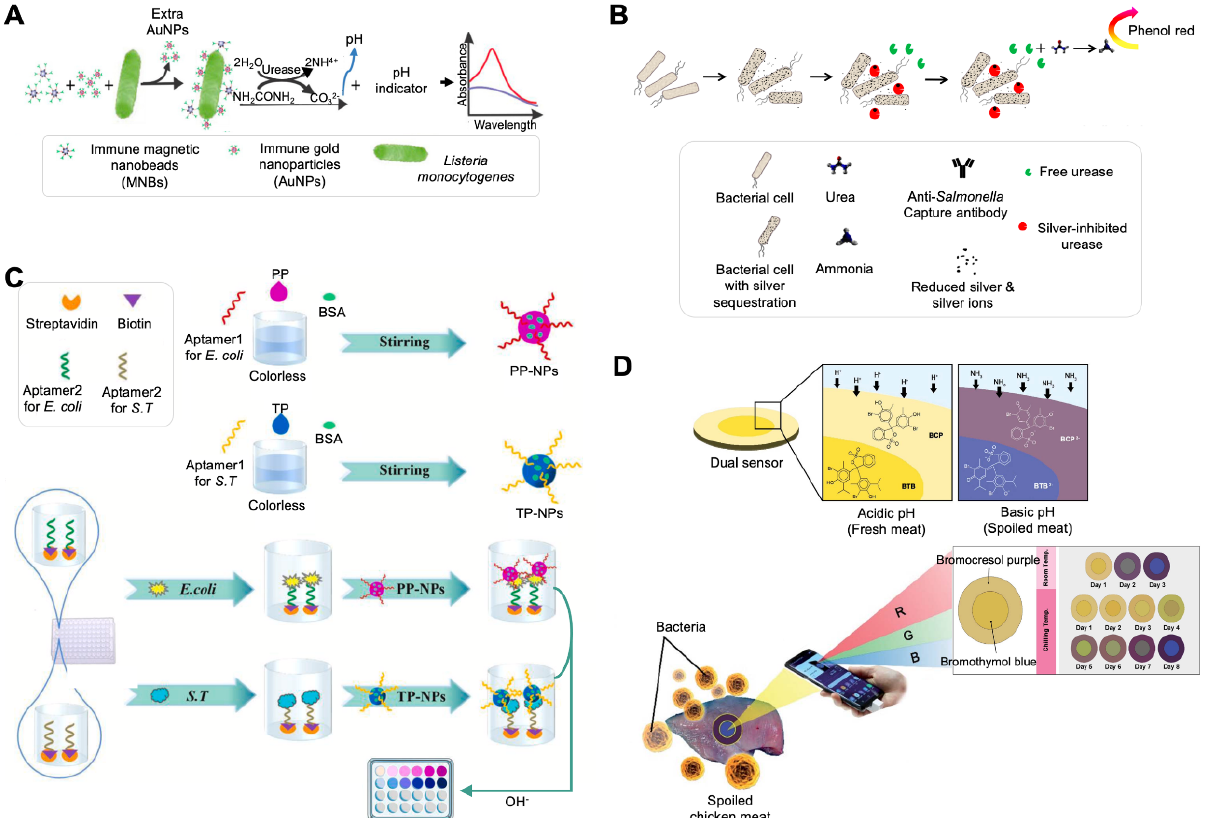
Figure 1. Colorimetric sensing strategy based on external pH change-induced pH indicator reac- tions. ( A ) Detection of Listeria monocytogenes using an antibody (Ab), urease-modified magnetic nanobeads, and gold nanoparticles (AuNPs). Reprinted with permission from [19]. Copyright 2017, Elsevier. ( B ) Detection of Salmonella typhimurium using silver ions and urease. This strategy is based on the Ag-induced inhibition of urease activity and Ag ion utilization. Reprinted with permission from [21]. Copyright 2020, Springer Nature. ( C ) Detection of Escherichia coli and S. typhimurium using two different pH-responsive NPs, which were made using PP or TP. Reprinted with permission from [22]. Copyright 2022, Elsevier. ( D ) Detection of bacterial spoilage using a paper-based pH indicator consisting of BTB and BCG. Quantification can be performed using RGB analysis software on a smartphone. Reprinted with permission from [23]. Copyright 2021, Royal Society of Chemistry. PEI, polyethyleneimine; BSA, bovine serum albumin; RGB,